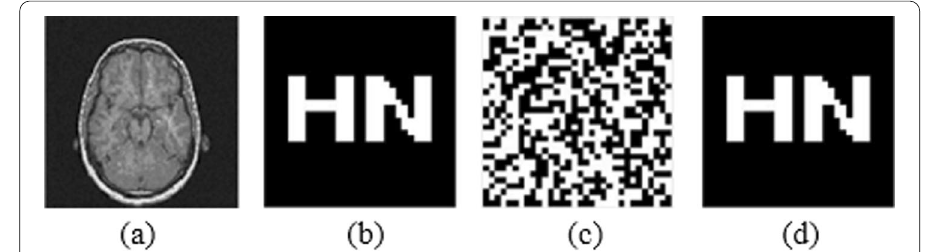
Fig. 5 Experimental images. a Original image, b Original watermark, c Scrambled watermark, d Extracted